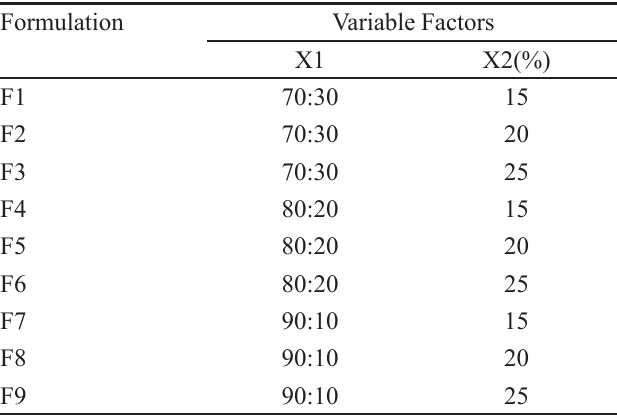
TABLE III - Different combinations of polymers and coating thickness